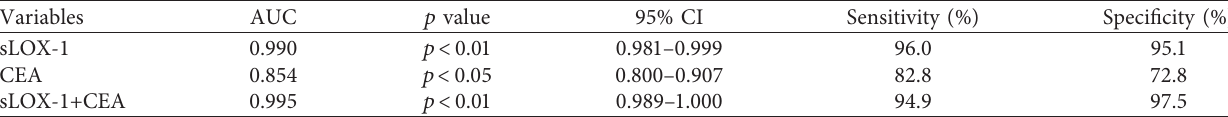
Table 5: The diagnostic value of sLOX-1 and CEA single index and combination for